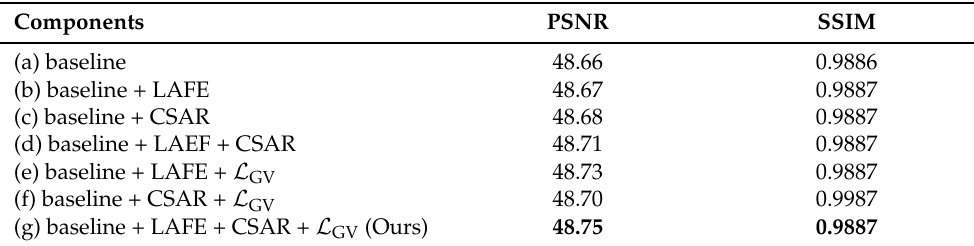
Table 2. Ablation analysis of the key components in the proposed model. (The best results are high- lighted in bold